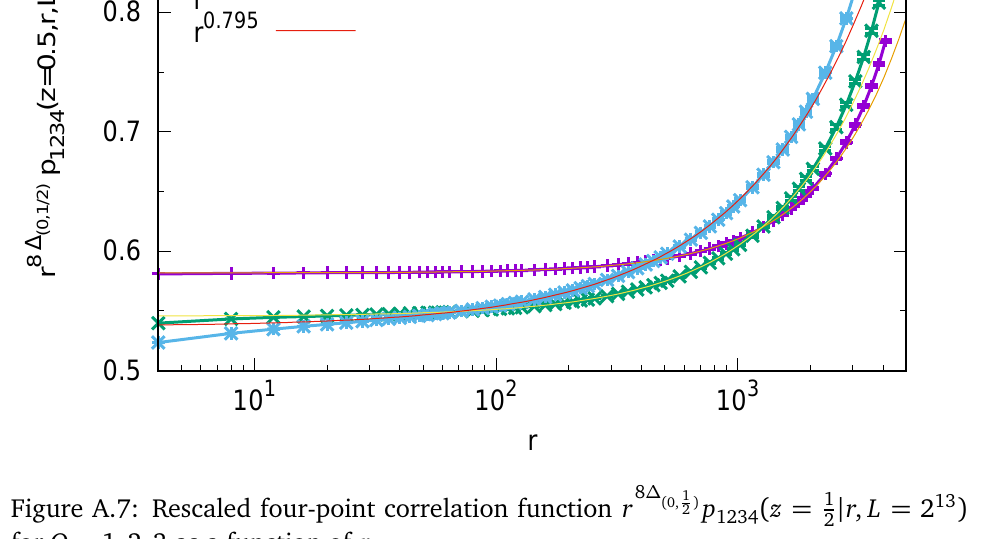
8 ∆ ( 0,1 ( z = 1 j r , L = 2 13 ) ) p 2 1234 2